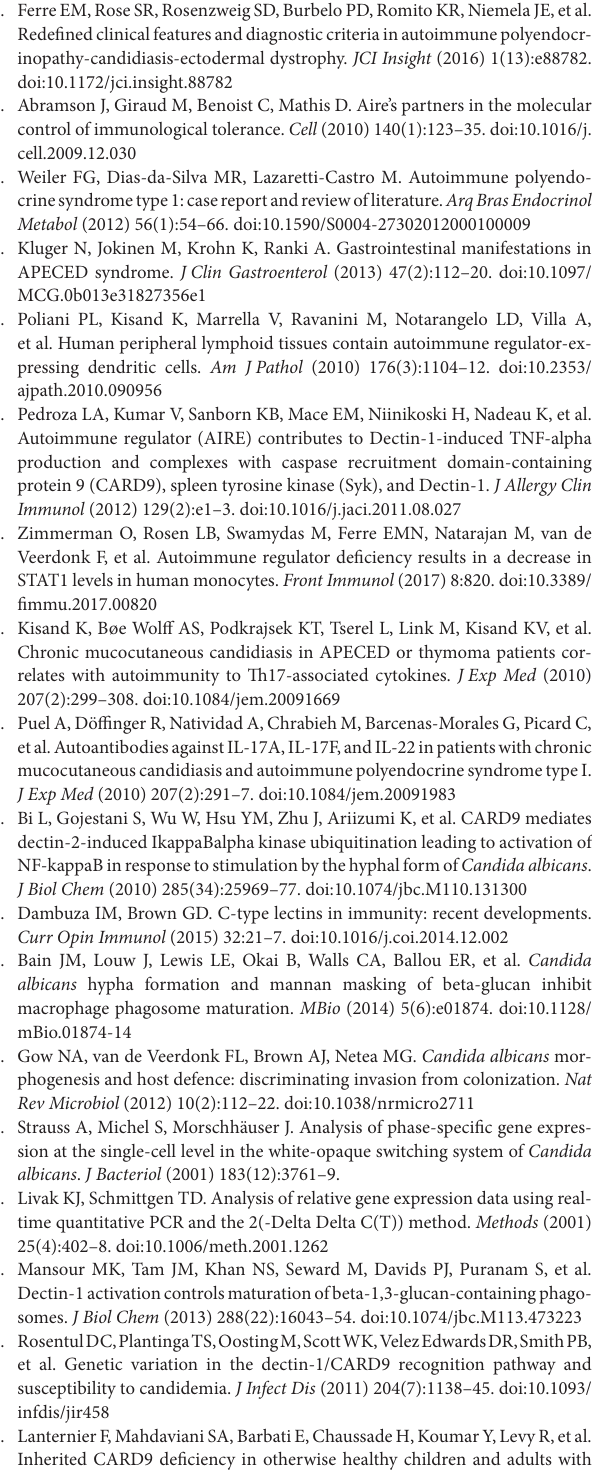
(B) IL-6 and TNF- α secretion by healthy donor or AIRE-deficient patient macrophages unstimulated or stimulated with LPS for 24 h. The horizontal bars denote the mean of four independent experiments for both healthy donors or APECED